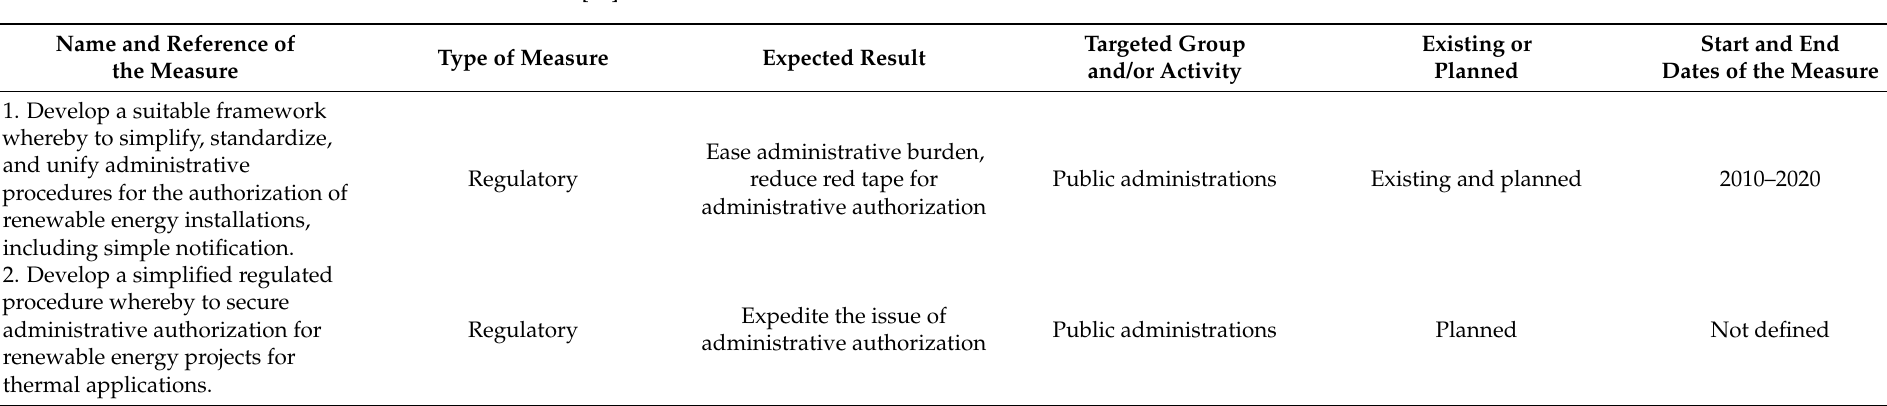
Table 4. General measures